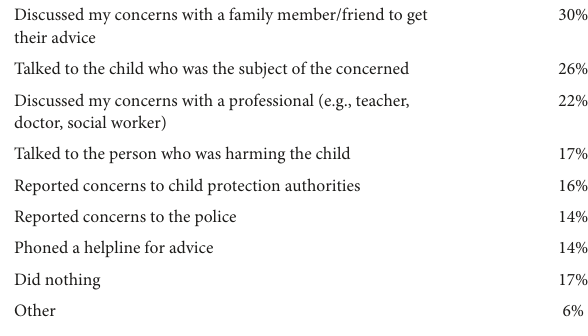
TABLE 10 Action taken by respondents in response to their